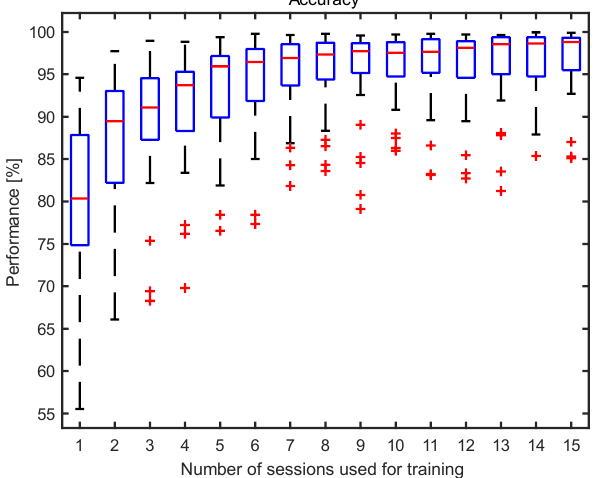
Figure 5. The box plots of accuracy versus the number of sessions used for training.